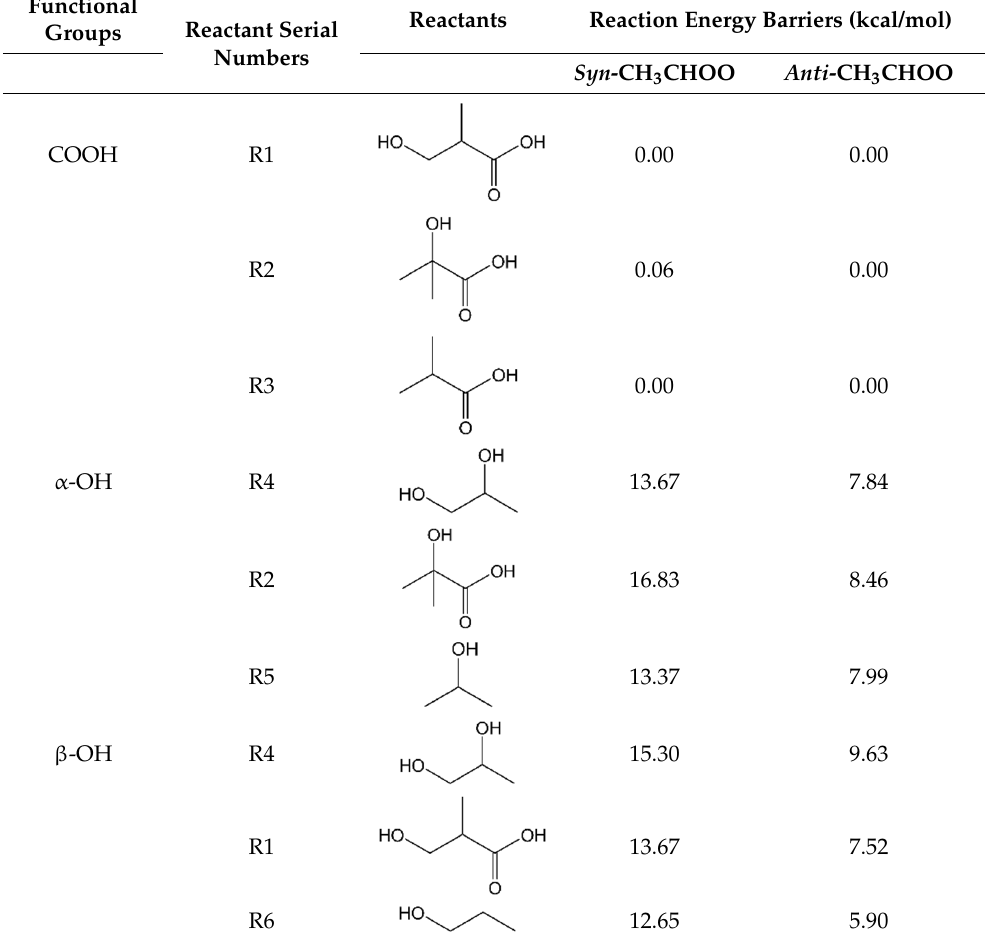
Table 1. The reaction energy barriers of CH 3 CHOO with the reactants obtained by replacing the functional groups of MGA with H atom.